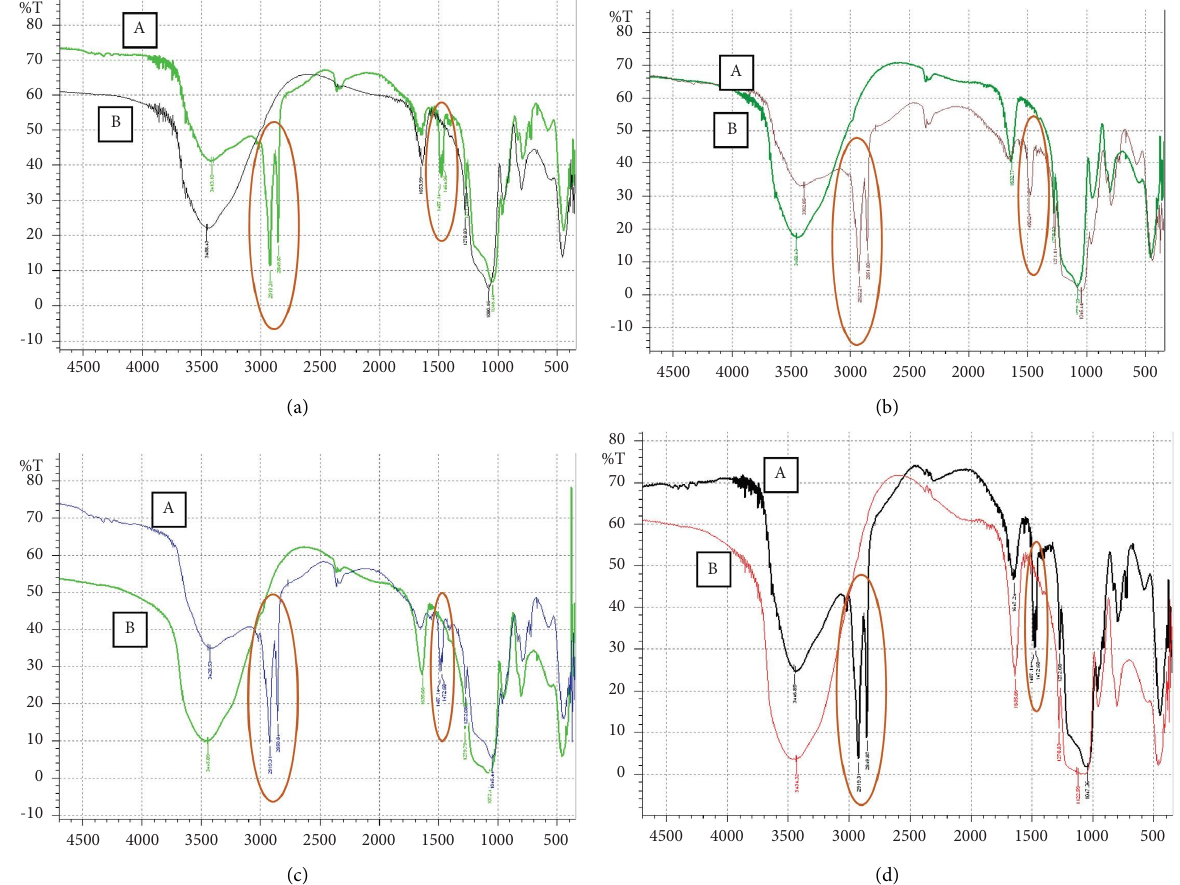
Figure 2: Infrared spectra of MIPMS and NIPMS: (a) A, MIPMS-1 before extraction; B, MIPMS-1 after extraction. (b) A, NIPMS-1 before extraction; B, NIPMS after extraction. (c) A, MIPMS-2 before extraction; B, MIPMS-2 after extraction. (d) A, NIPMS-2 before extraction; B, NIPMS-2 after extraction. Note: the red circle shows the disappearing absorption band after the extraction